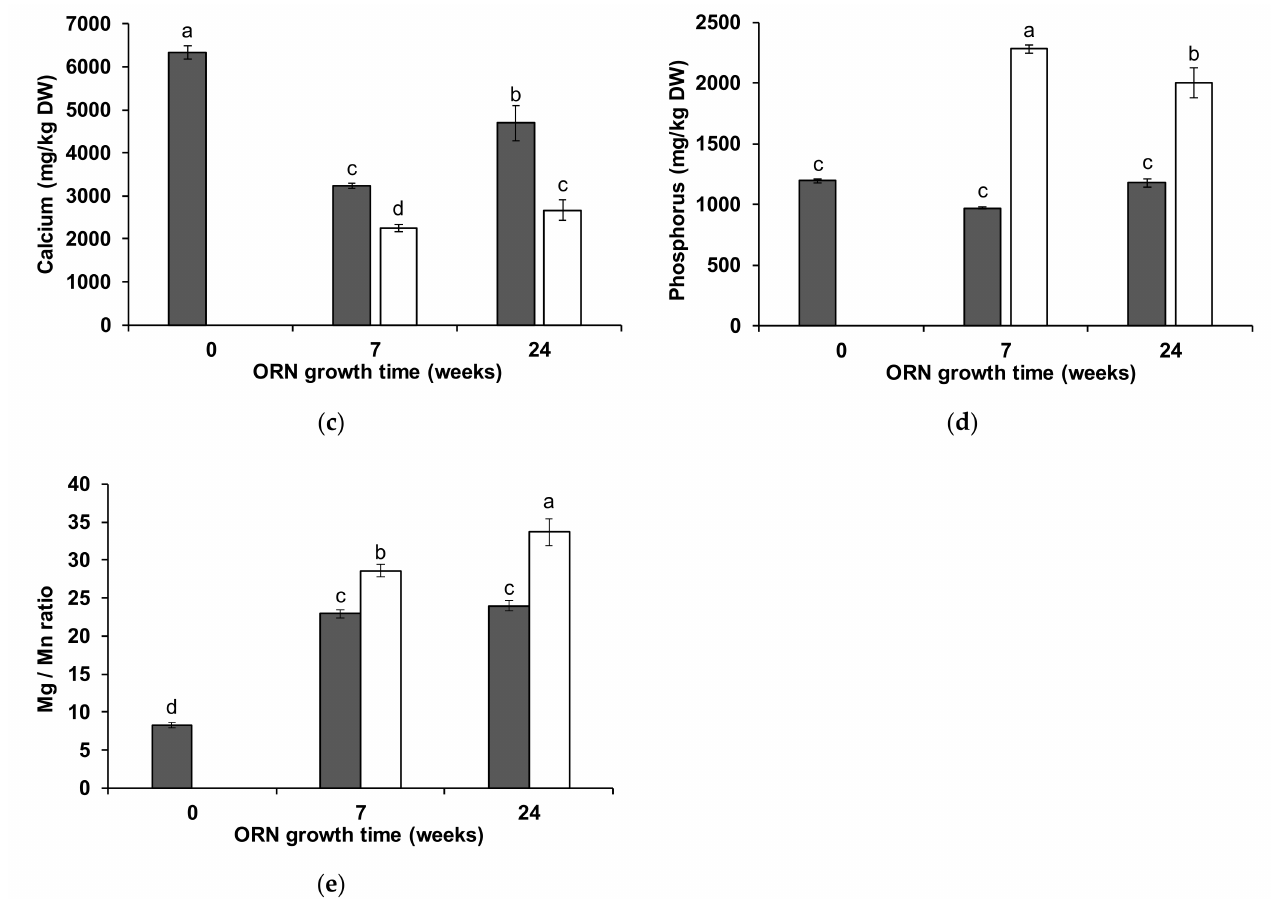
Figure 2. Concentrations (average and standard error) of manganese ( a ), magnesium ( b ), calcium ( c ), phosphorus ( d ) (mg element/kg of shoot dry weight (DW)) and Mg/Mn ratios ( e ) in shoots of wheat grown in disturbed (grey columns) or undisturbed (white columns) soil with previously grown Ornithopus compressus (ORN), after 0, 7 or 24 weeks. Different letters indicate statistically significant differences ( p < 0.05) based on Tukey’s